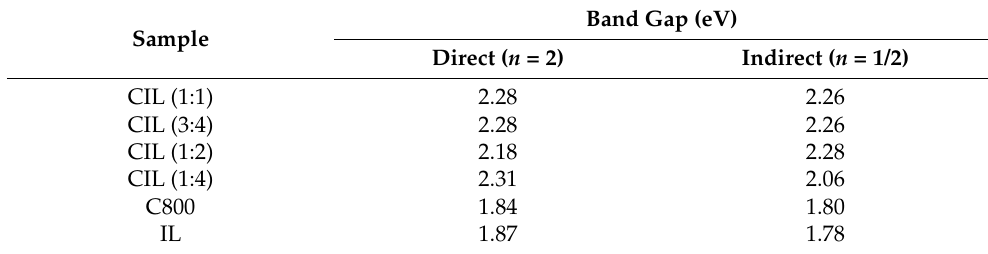
Figure 8. Tauc plots showing the indirect transitions of the synthesized materials. Table 2. The band gap values calculated from direct and indirect